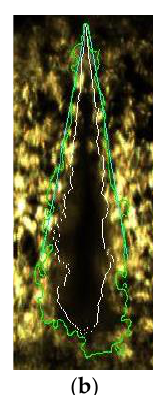
Figure 7. Comparison of the spray shape at 0.9 ms for Case 1. ( a ) Liquid- and vapor-phase spray of simulation; ( b ) Liquid- and vapor-phase spray of experiments.